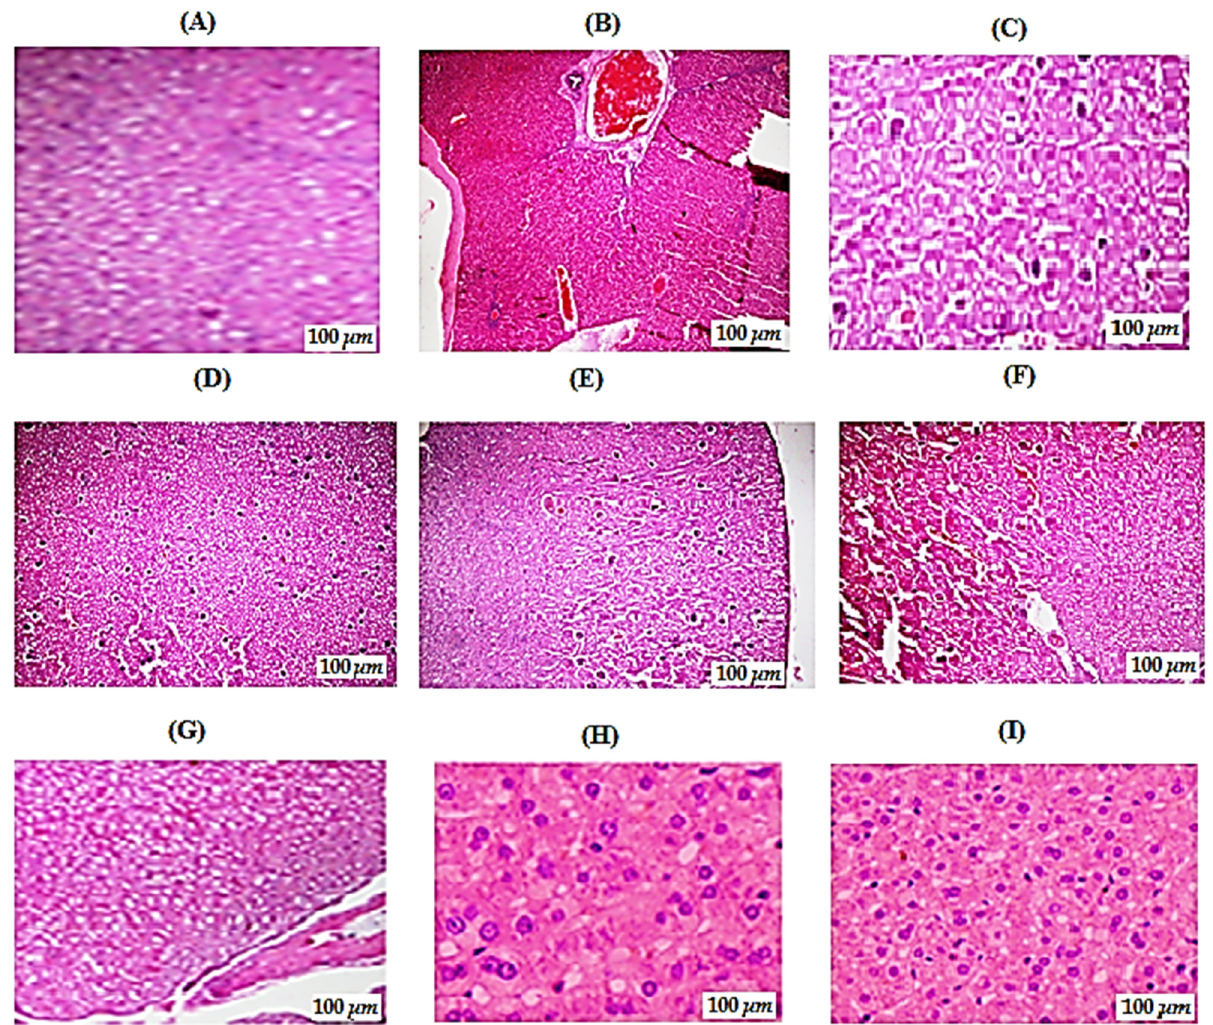
Figure 6. Effects of morin (2, 5, 10, 15, 30, and 50 mg/kg) and glibenclamide (5 mg/kg) on pancreas histopathology in STZ-induced diabetic rats. ( H , E ) staining; 40 × and 100 × , scale bar = 100 µ m: ( A ) control group; ( B ) diabetic control group; ( C ) glibenclamide (5 mg/kg/overly) treated group; ( D , E ) morin (2, 5 mg/kg/orally) treated group; ( F , G ) morin (10, 15 mg/kg/orally) treated groups; ( H , I ) morin (30 and 50 mg/kg/orally) treated group.